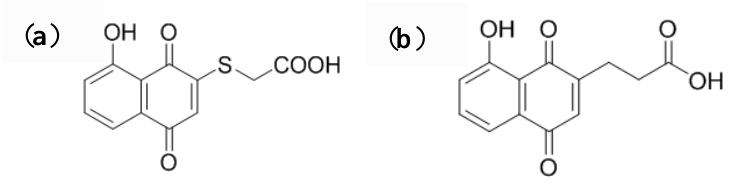
Figure 4. ( a ) Structure of 5-hydroxy-2-thioacetic acid-1,4-naphthoquinone) (HSNQA) and ( b ) 5-hydroxy-1,4-naphthoquinone-3-propionic acid